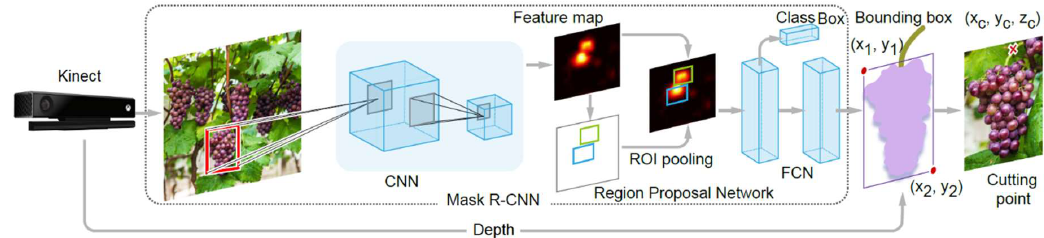
Figure 6. Illustration of the vision system that detects and localizes the crop and its cutting point.